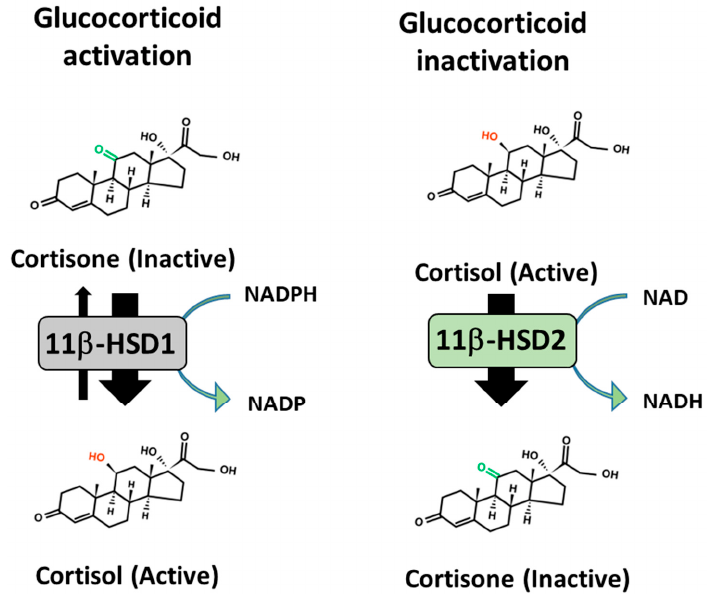
Figure 4. Pre-receptor metabolism of GCs by 11 β -HSD1. 11 β -hydroxysteroid dehydrogenase (11 β -HSD) type 1 is a bidirectional enzyme that predominantly reduces inactive GCs to their active counterparts in an NADPH dependent manner, whilst 11 β -HSD type 2 is an NAD + dependent unidirectional enzyme that converts active GCs to their inactive